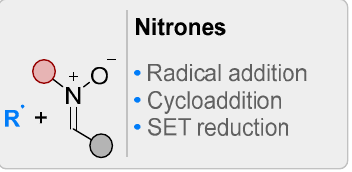
Figure 3. Radical-based transformations of azomethine imines.